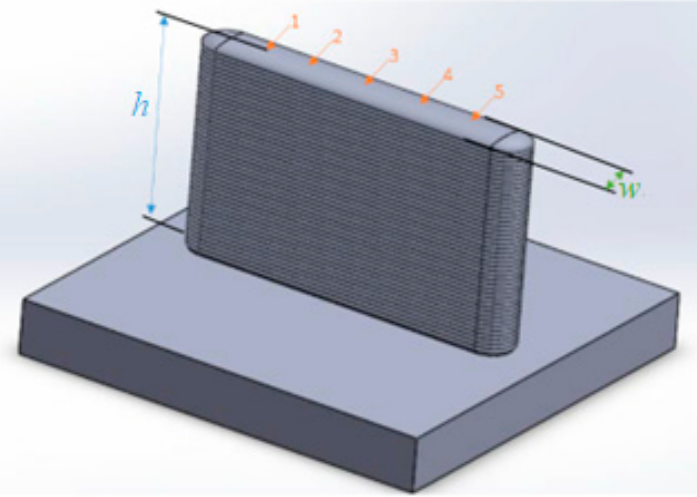
Figure 4. Measuring procedure of the layer’s height ( h ) and width ( w ) at points 1–5. The E and F tests were measured with the Trimek Zubi CNC 50.40.30. coordinate measuring machine (CMM) with a TP2 Renishaw probe and 4 mm spherical stylus. The CMM helped to measure the orientation of the walls ( α ), as shown in Figure 5a,b. Figure 5a shows a generic inclined wall, and Figure 5b shows a horizontal wall in which the sub- strate lays in the vertical position. Of special interest is the comparison of the top and bottom results because of the possible influence of the heat accumulated in the bottom of the inclined walls.